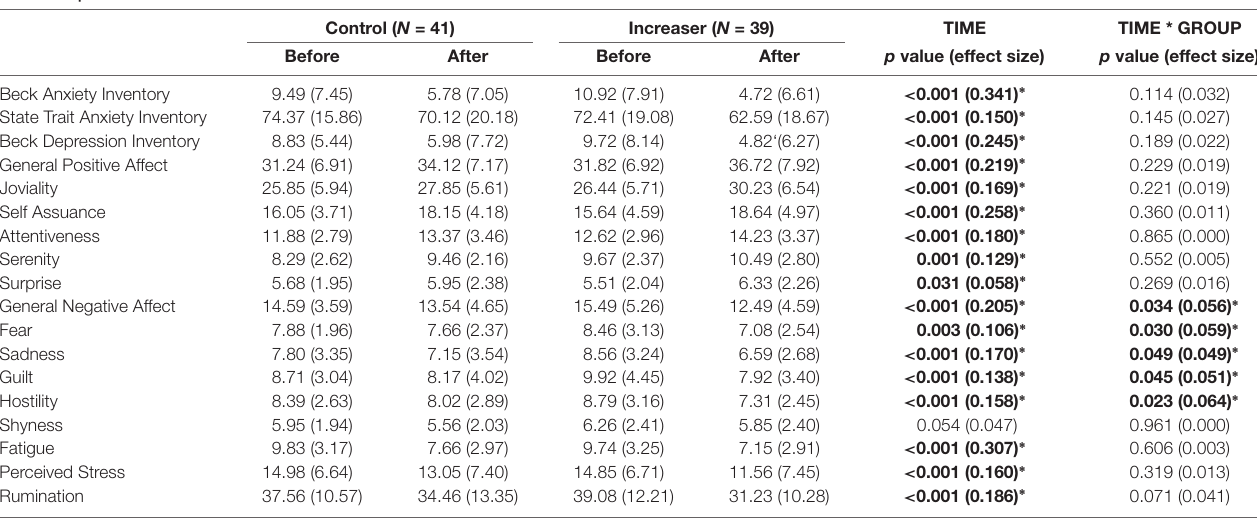
TABLE 3 | Affective state measures. Control ( N = 41) Increaser ( N = 39) TIME Before After